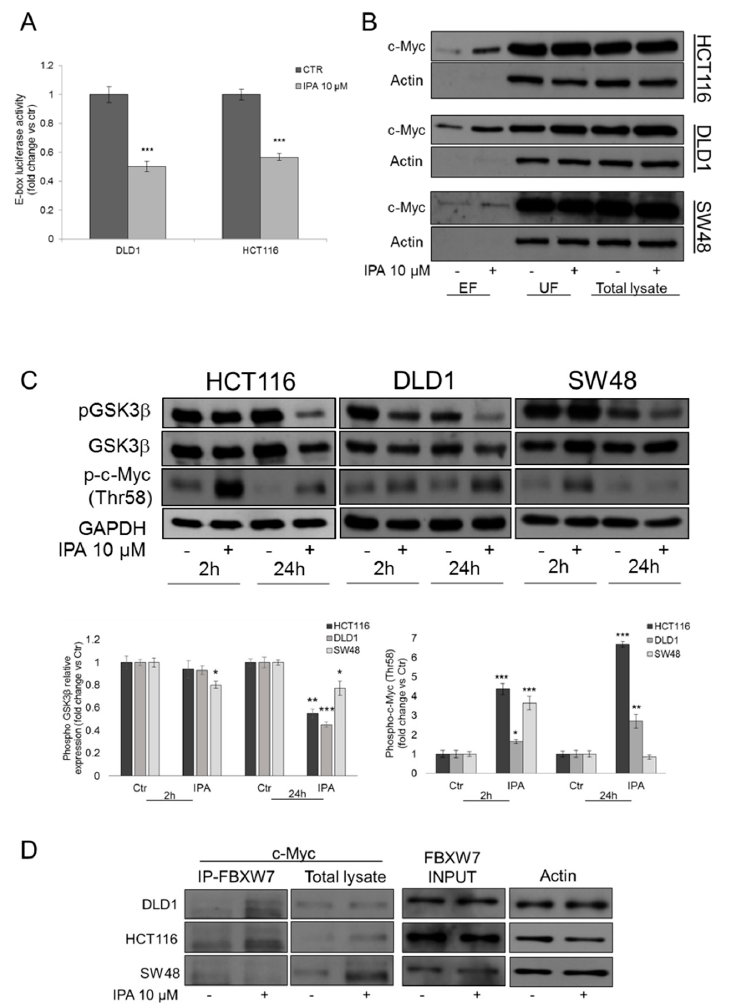
Figure 3. IPA a ff ects c-Myc transcriptional activity through its ubiquitination. ( A ) Analysis of luciferase activity controlled by E-box elements in HCT116 and DLD1 cell lines. The histograms represent luciferase activity measured at 18 h from transfection of HCT116 and DLD1 cells transfected with reporter construct containing the E-box elements for c-Myc and treated with IPA 10 µM or vehicle. Firefly luciferase was normalized to Renilla luciferase reading and the data were plotted as fold change (mean ± SD of four independent experiments in triplicate; unpaired two tailed Student’s t -test *** p < 0.005) compared to control cells. ( B ) Representative western blot analysis of c-Myc expression in eluted fraction (EF) containing ubiquitinated proteins, unbound fraction (UF) depleted of ubiquitinated protein and whole protein lysates from HCT116, DLD1 and SW48 cells, treated with IPA 10 µM for 2 h. Actin was used as loading control. ( C ) Representative western blot and densitometry analysis of phosphorylated (Thr-58) c-Myc, phosphorylated (Ser9) GSK3 β and total GSK3 β in HCT116, DLD1 and SW48 cells treated with IPA 10 µM at the indicated time points. The histogram represents densitometry analysis of phosphorylated (Thr-58) c-Myc (right) or phosphorylated GSK3 β expressed as fold change vs. total GSK3 β (left), normalized vs. GAPDH. Data are expressed as mean ± SD of five independent experiments. * p < 0.05, ** p < 0.01, *** p < 0.005 vs. control. ( D ) DLD1, HCT116 and SW48 cells were treated with IPA or vehicle for 2 h. FBXW7 was Immunoprecipitated using anti-FBXW7 antibody. c-Myc expression was analyzed in FBXW7-IP fractions (to assess the reciprocal binding) and total cell lysates. FBXW7 protein levels before the IP was used as INPUT and Actin was used as loading control. Blots are representative of at least three independent experiments.